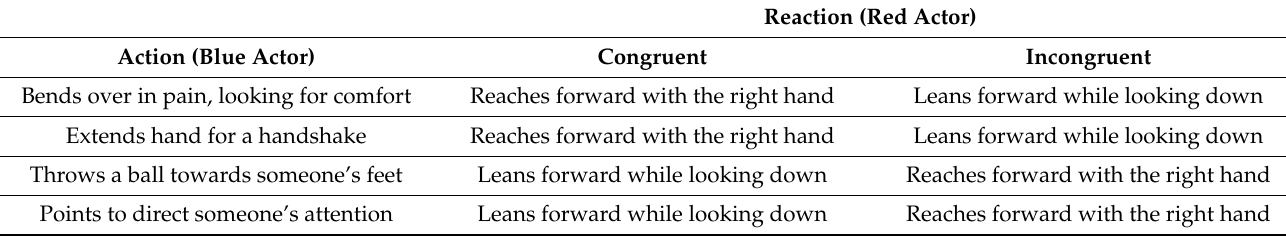
Table A1. Action–reaction sequences in Block A.